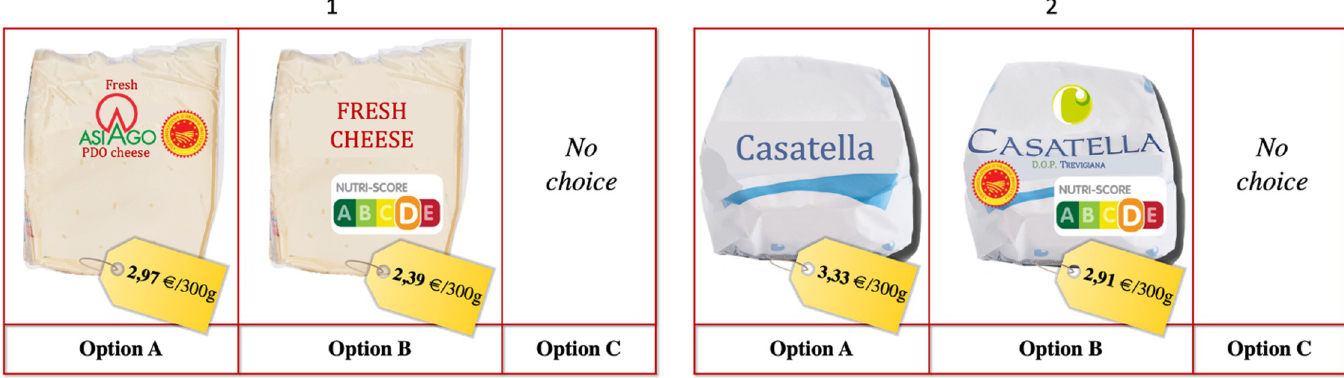
Fig 2. Example of a choice set for Block 1 (1) and Block 2 (2). Note . The original choice tasks are presented to the respondents in Italian. In the figure, terms are translated in English to facilitated the understanding of the readers. Source . Our elaboration.